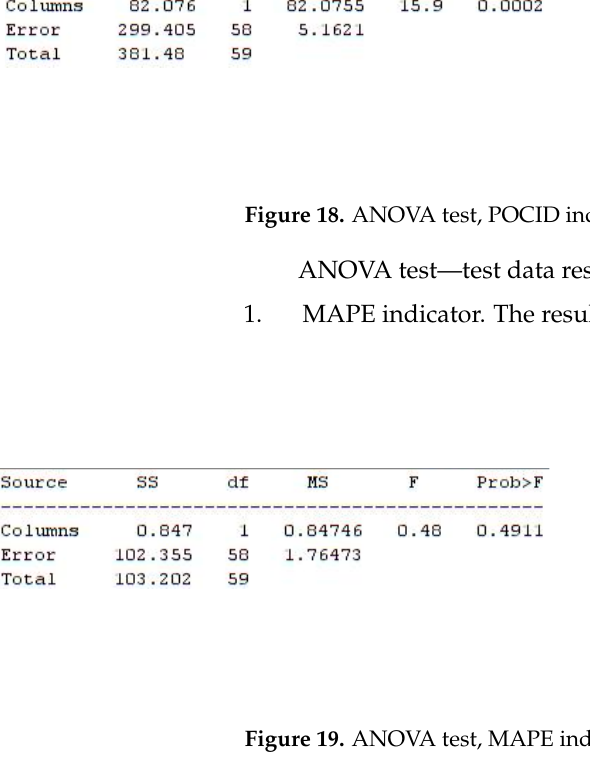
2. F 1 indicator. The result indicates a dissimilarity between the F 1 values, and the one corresponding to the proposed method is slightly better.